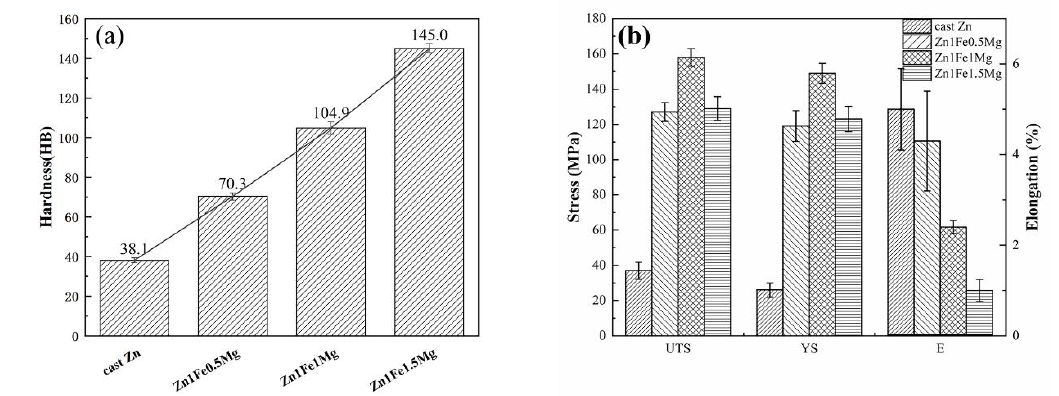
Figure 3. Microhardness ( a ) and tensile properties ( b ) of alloys with different Mg